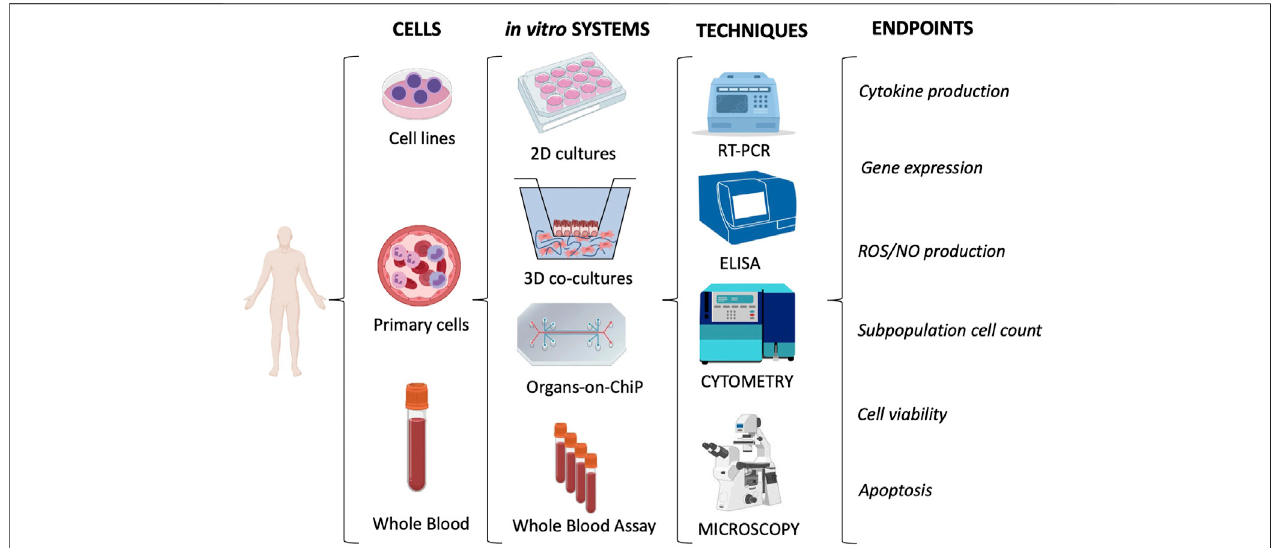
FIGURE4| Immunotoxicityevaluationinhumancells.Themostused invitro models/systemsarebasedoncelllinesorprimarycells( e.g. ,leukocytesisolatedfrom whole blood). They encompass conventional 2D cultures, 3D co-cultures and the more innovative Organs-on-ChiP arrays. The whole blood can be considered as a “ ready-to-use ” system. 2D cultures with monocytic cell lines ( e.g. , THP-1 or U937) or with the more reliable primary cells (e.g., monocytes, NK or DC) are mainly used to measure the in fl ammatory reactivity of innate immune cells. Conversely, the Whole Blood Assay (WBA; based on the use of anticoagulated whole blood) allows us to study the global reactivity ofblood cells. Overall,the immunotoxicity is evaluated by measuring several biological and functional endpoints through different evaluation techniques. The main techniques and endpoints are shown.